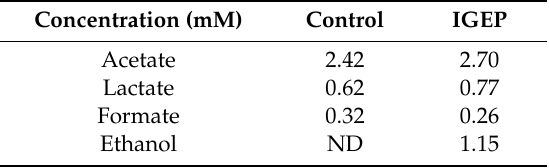
Table 1. Metabolite analysis by B. infantis following 24 h incubation with IGEP. Concentration values (mM) are the average of three biological replicates, each analyzed in technical